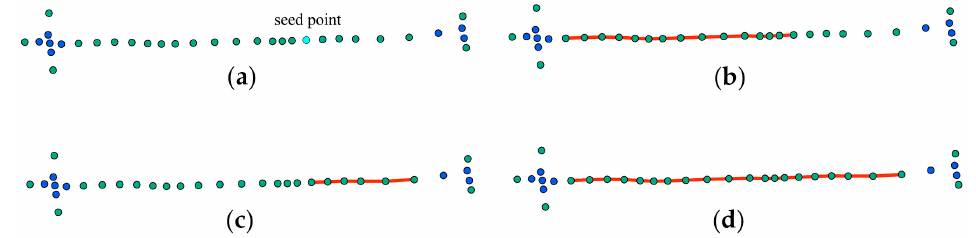
Figure 2. Process of road segment growth. The green dots are candidate points and linearly distributed. ( a ) Seed point (highlight point) with the largest distribution characteristics value; ( b ) trace along the dominant principal component analysis direction of the seed point; ( c ) trace along the direction opposite the dominant PCA direction of the seed point; and ( d ) merged search results in both directions.